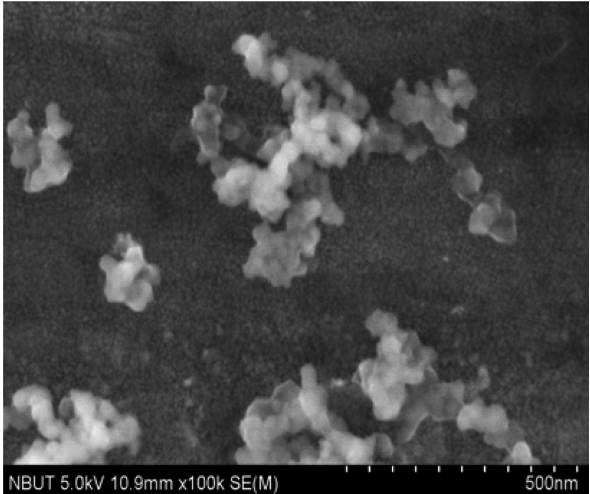
Figure 5 SEM morphology of particle distribution of modified nano- silica